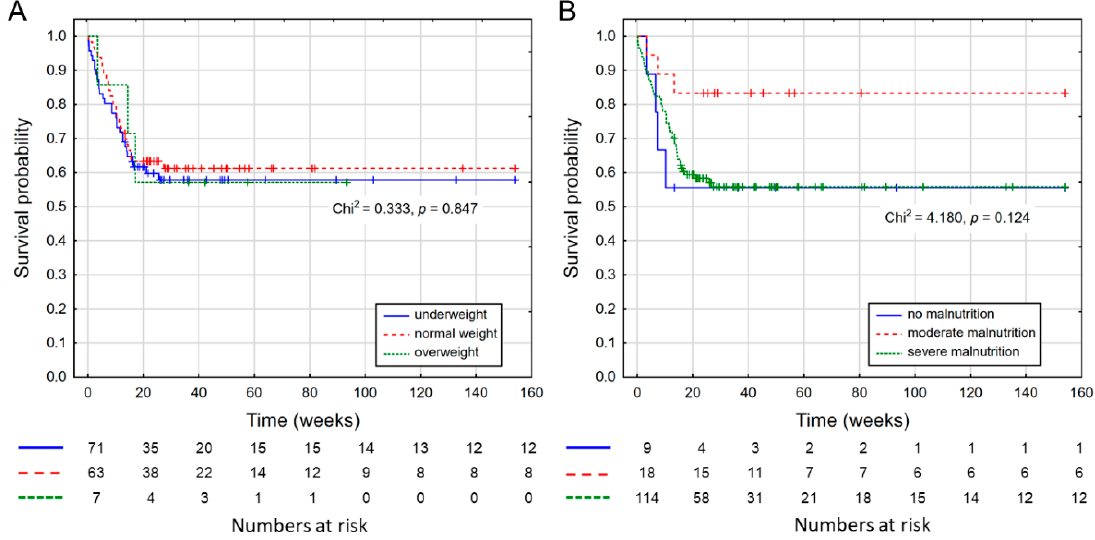
Figure 2. Survival curves of all subjects; ( A ) according to BMI; ( B ) according to GLIM. As NRI and GNRI are age-dependent indicators of malnutrition risk, the analyzed group was as follows: NRI, patients below 65 years old ( n = 83); GNRI, patients ≥ 65 years old ( n = 74). The results for NRI and GNRI are shown in Figure 3.